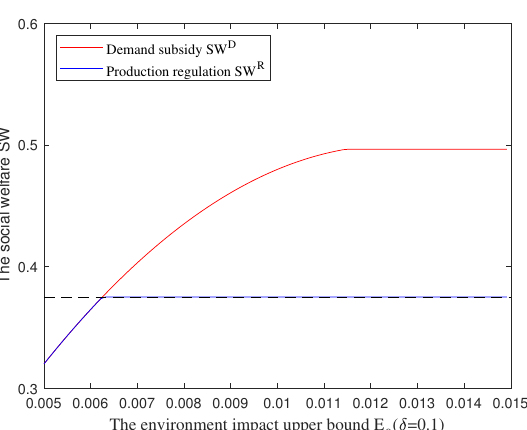
Figure 4. The social welfare under two types of policies with the change in the environment impact upper bound E 0 ( δ = 0.1 ) .